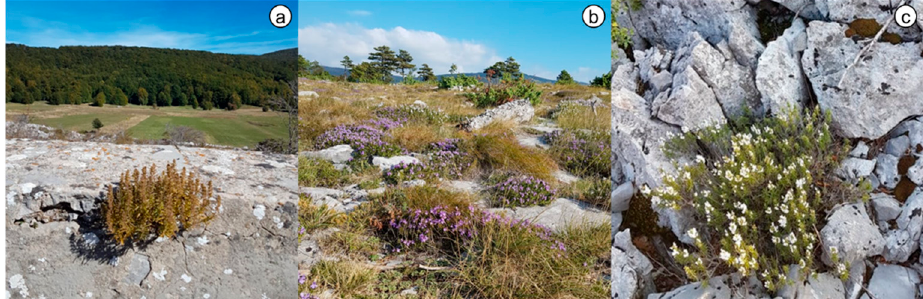
Figure 1. Locations of the collected seeds of three natural populations of winter savory [( a )—Stolac (P1); ( b )—Ron č evi ć Dolac (P2); ( c )—Trbušnjak (P3)].